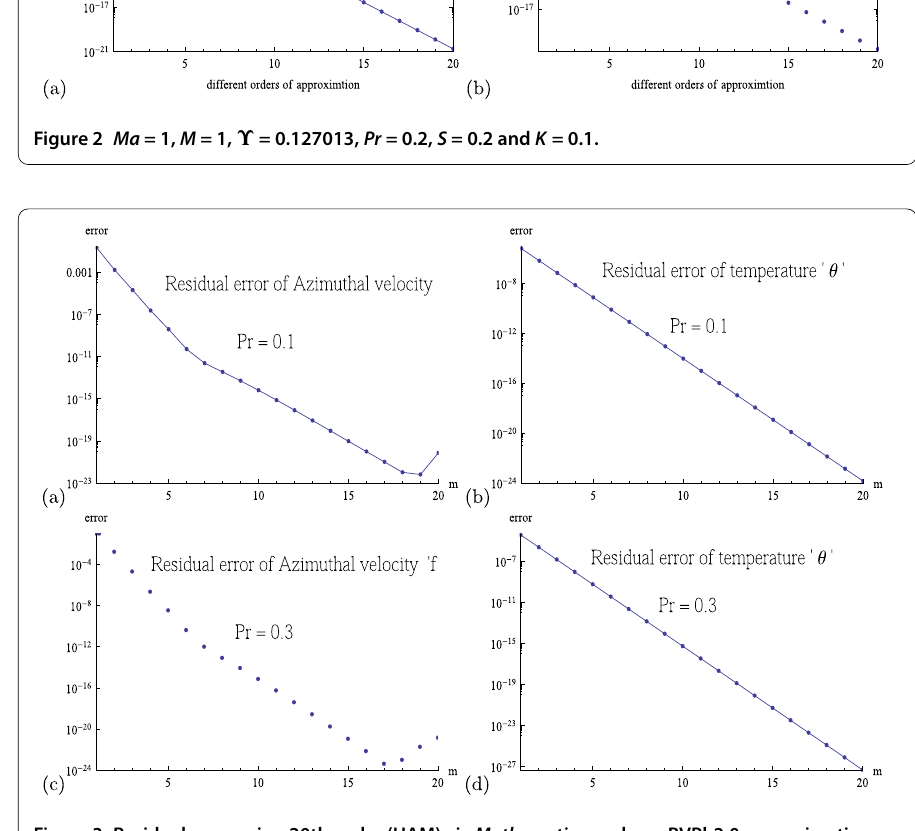
Figure 3 Residual error using 20th-order (HAM) via Mathematica package BVPh2.0 approximation, where Ma = 1, M = 1, ϒ = 0.127013, K = 0.1, Gr = 5 and S =